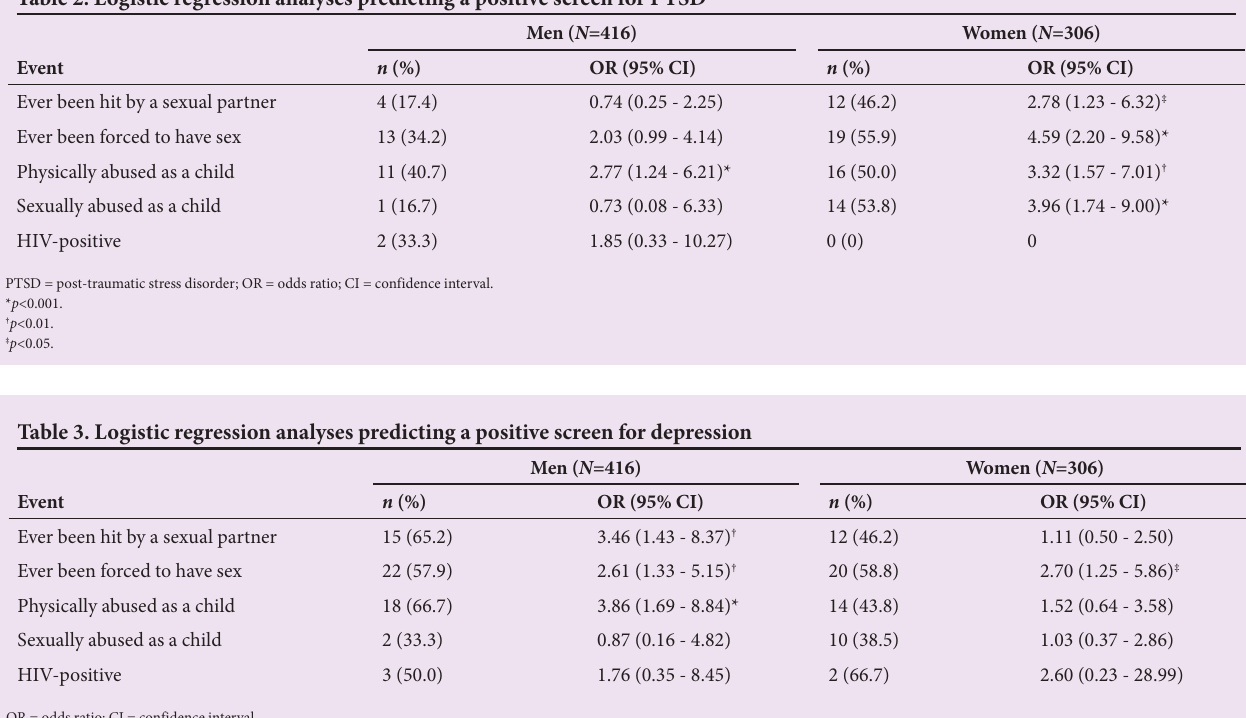
Table 2. Logistic regression analyses predicting a positive screen for PTSD Men ( N =416) Women ( N =306) Event n (%) OR (95% CI) n (%) OR (95% CI) Ever been hit by a sexual partner 4 (17.4) 0.74 (0.25 - 2.25) 12 (46.2) 2.78 (1.23 - 6.32) ‡ Ever been forced to have sex 13 (34.2) 2.03 (0.99 - 4.14) 19 (55.9) 4.59 (2.20 - 9.58)* 11 (40.7) 2.77 (1.24 - 6.21)* 16 (50.0) 3.32 (1.57 - 7.01) † 1 (16.7) 0.73 (0.08 - 6.33)